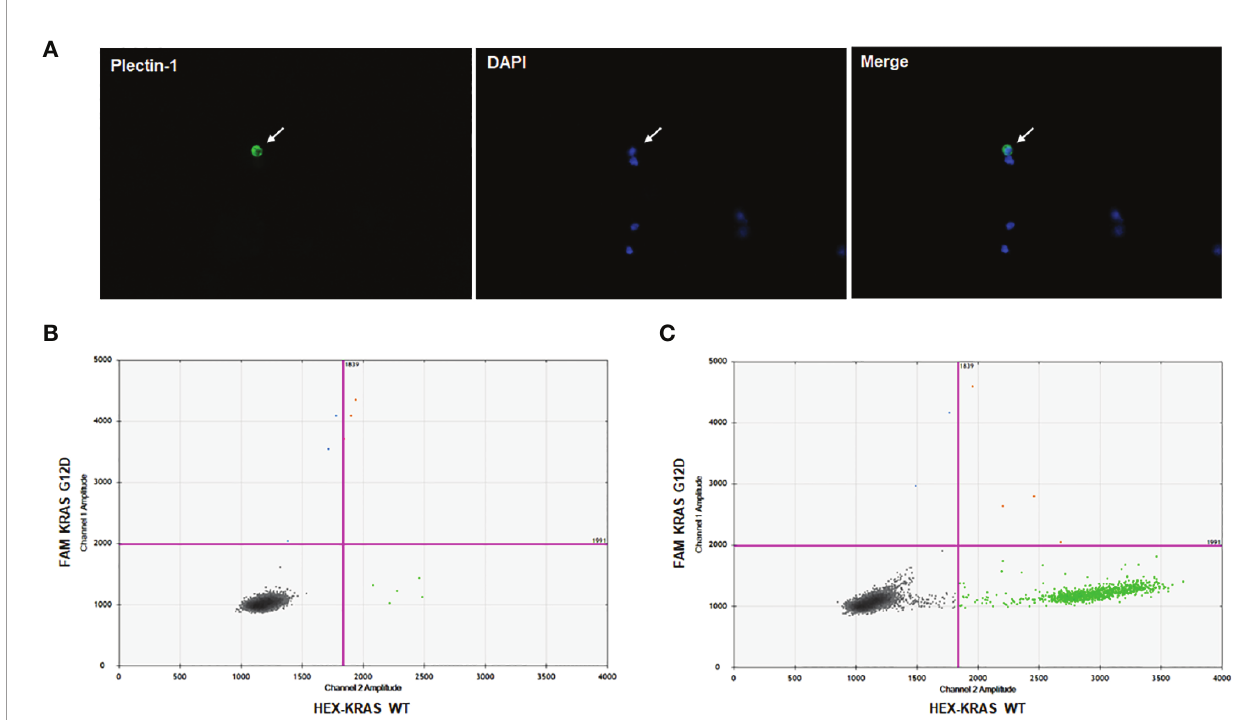
FIGURE 2 | Plectin-1 + cell isolation and KRAS mutation analysis. To clarify Plectin-1-expressing cells in the blood, immuno fl uorescence staining was carried out to isolate Plectin-1-expressing cells, and ddPCR for KRAS wildtype (WT) and mutant (G12D) was performed. (A) A representative image of the circulating tumor cell (CTC) stained with Plectin-1 antibody (green) and 4 ’ 6-diamidino-2-phenylindole (DAPI) (blue). Arrow indicates the Plectin-1 + CTC. The detection of KRAS G12D mutation in (B) Plectin-1 + CTCs and (C) all capture cells on the microfabricated porous fi lter in the same patient.